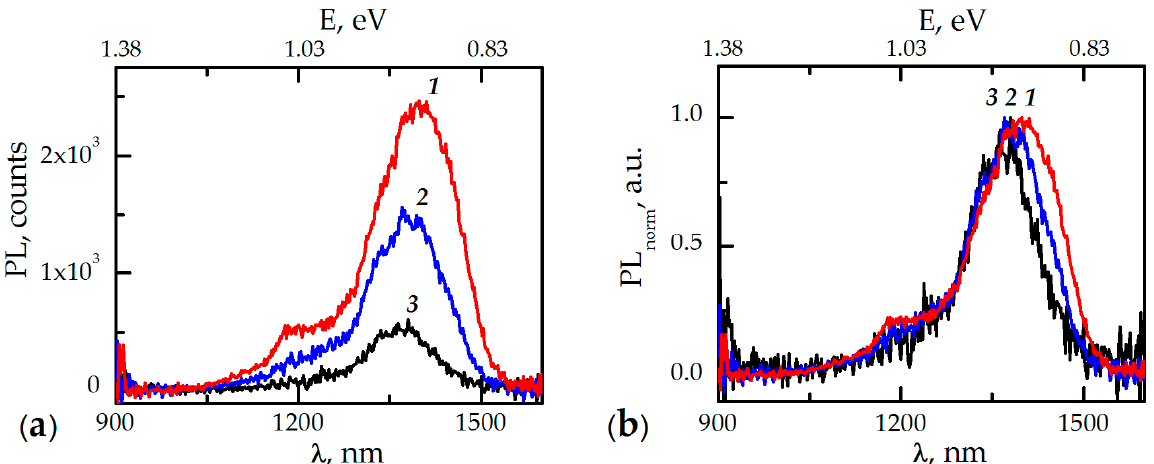
Figure 1. The absolute ( a ) and normalized ( b ) photoluminescence (PL) spectra of the InAsPnanoinsertions measured at 300 K: 1 is in the absence of the trioctylphosphine oxide (TOPO) ligand shell; 2 is for 7 × 10 − 7 mol/L TOPO concentration; and 3 is for 1.5 mol/L TOPO concentration.